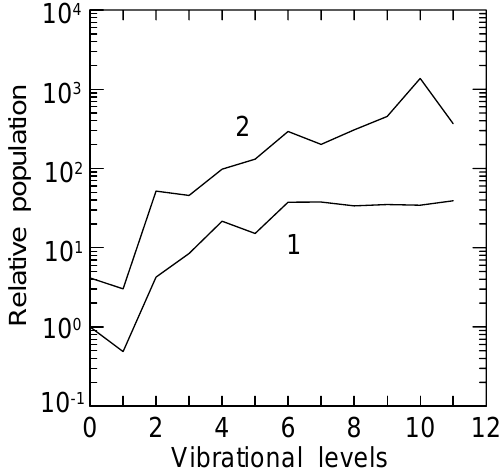
Fig. 12. The same as in Fig.11, but for the A 0 3 1 u state: 1 and 2 – Fig. 11. The calculated relative vibrational populations of the c 1 6 − u without and with the contribution of the process (4b). state of O 2 at the altitude of 80km: 1 and 2 – without and with the Fig.11. contribution of the process (4b).